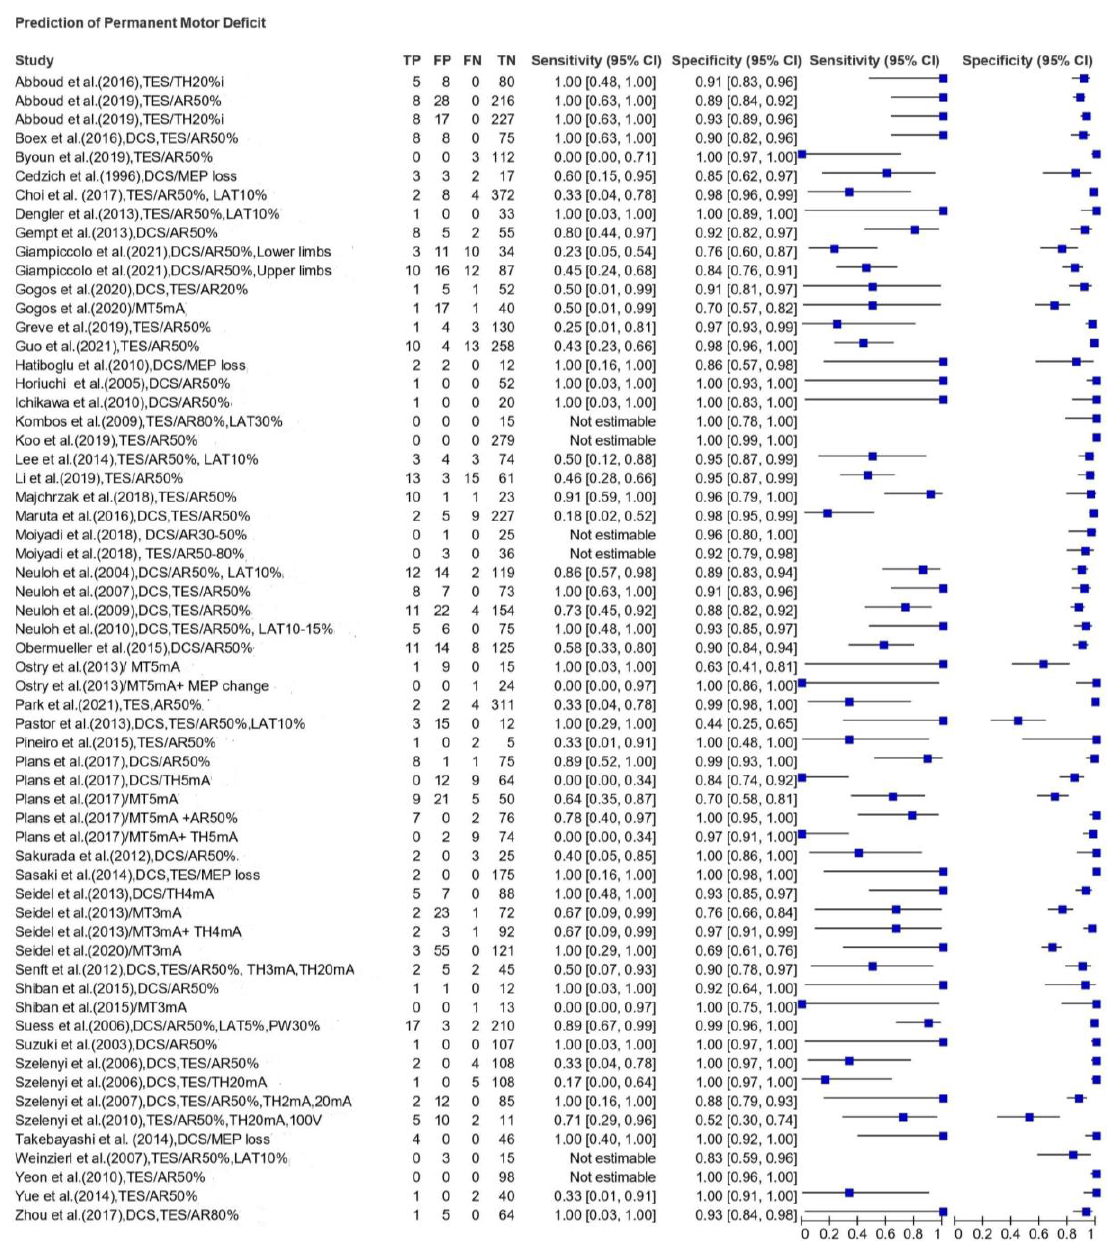
Figure 3. Forest plot of sensitivity and specificity estimates for permanent motor deficits AR: Amplitude criterion; DCS: Direct Cortical Stimulation; FN: False Negative; FP: False Positive; i: ipsilateral; LAT: Latency criterion; MEP: Motor Evoked Potential; MT: Motor Threshold/Mapping criterion; PW: Pulse Width Increase; TES: Transcranial Electrical Stimulation; TH: Threshold criterion; TN: True Negative; TP: True Positive.